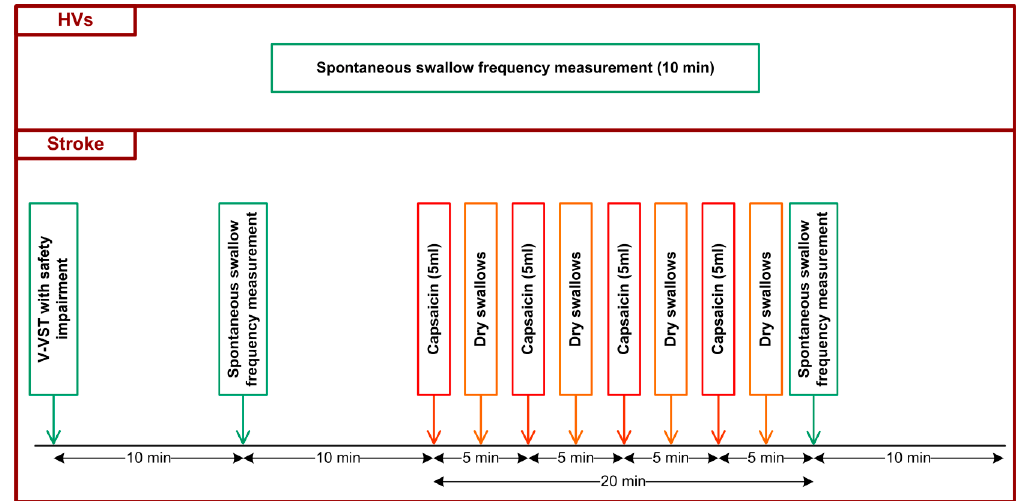
Figure 1. Study design of the two populations included in the study: HV at the top, post-stroke patients at the bottom.